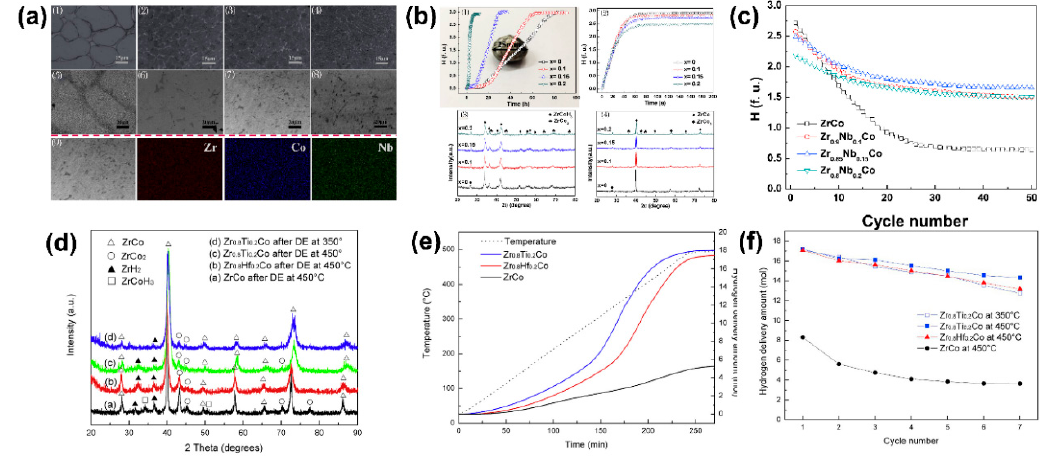
Figure 2. ( a ) Metallographic (1–4) and Back-scattered electron imaging (BSE) (5–8) micrographs of Zr 1–x Nb x Co alloys: (1), (5) x = 0; (2), (6) x = 0.1; (3), (7) x = 0.15; (4), (8) x = 0.2. Energy dispersive X-ray